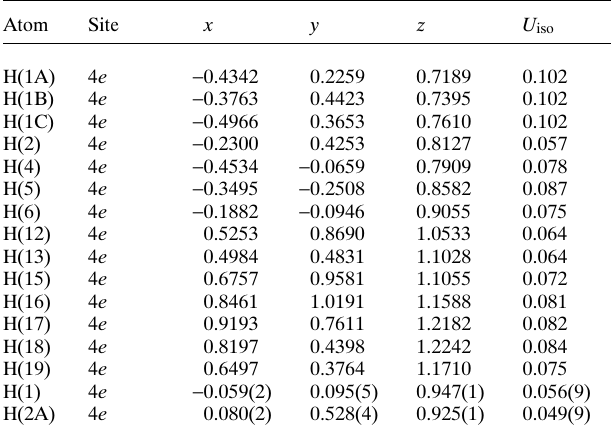
Table 2. Atomic coordinates and displacement parameters (in Å 2 ) .